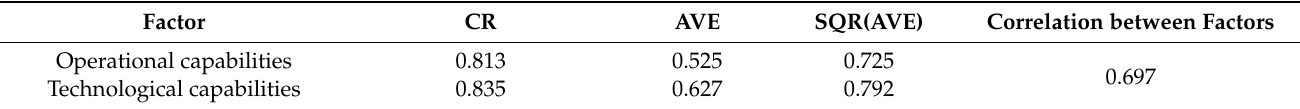
Table 10. CFA model validity